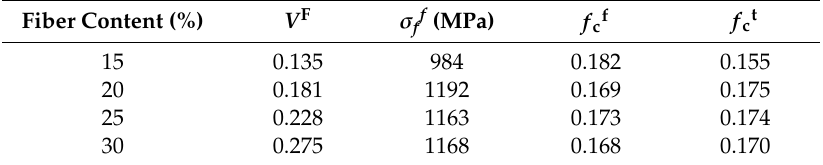
Table 3. Coupling factor ( f c ) of PLA–BSKF composites by flexural and tensile